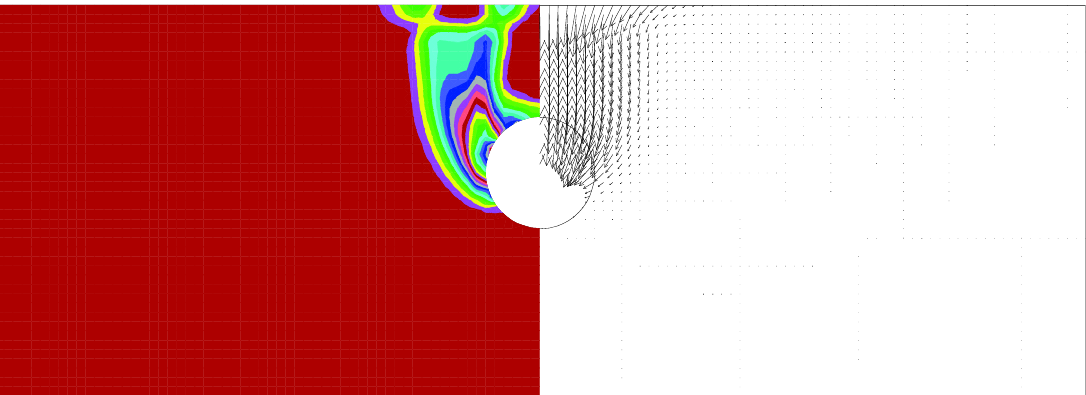
Figure 9. Shear strain rate (SSR) and velocity plot for C/D = 1, γD/S u = 1 .